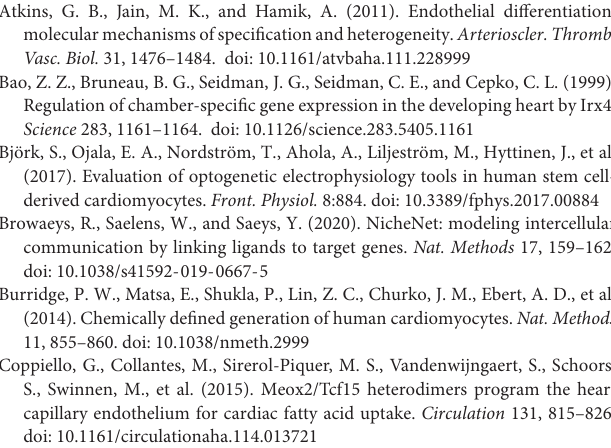
Supplementary Figure 1 | Expression of cardiomyocyte markers during differentiation. qPCR analysis shows that CM marker gene expression is increased during differentiation. Two differentiation experiments [HEL47.2 (1.) and HEL47.2 (2.)] with two replicates each are shown. Expression levels have been normalized by comparing to day 1.